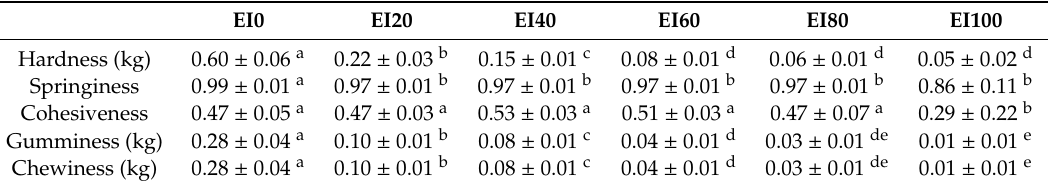
Table 2. Texture profile analysis of emulsion prepared with the interaction between porcine myofibrillar protein and extracted edible insect protein.